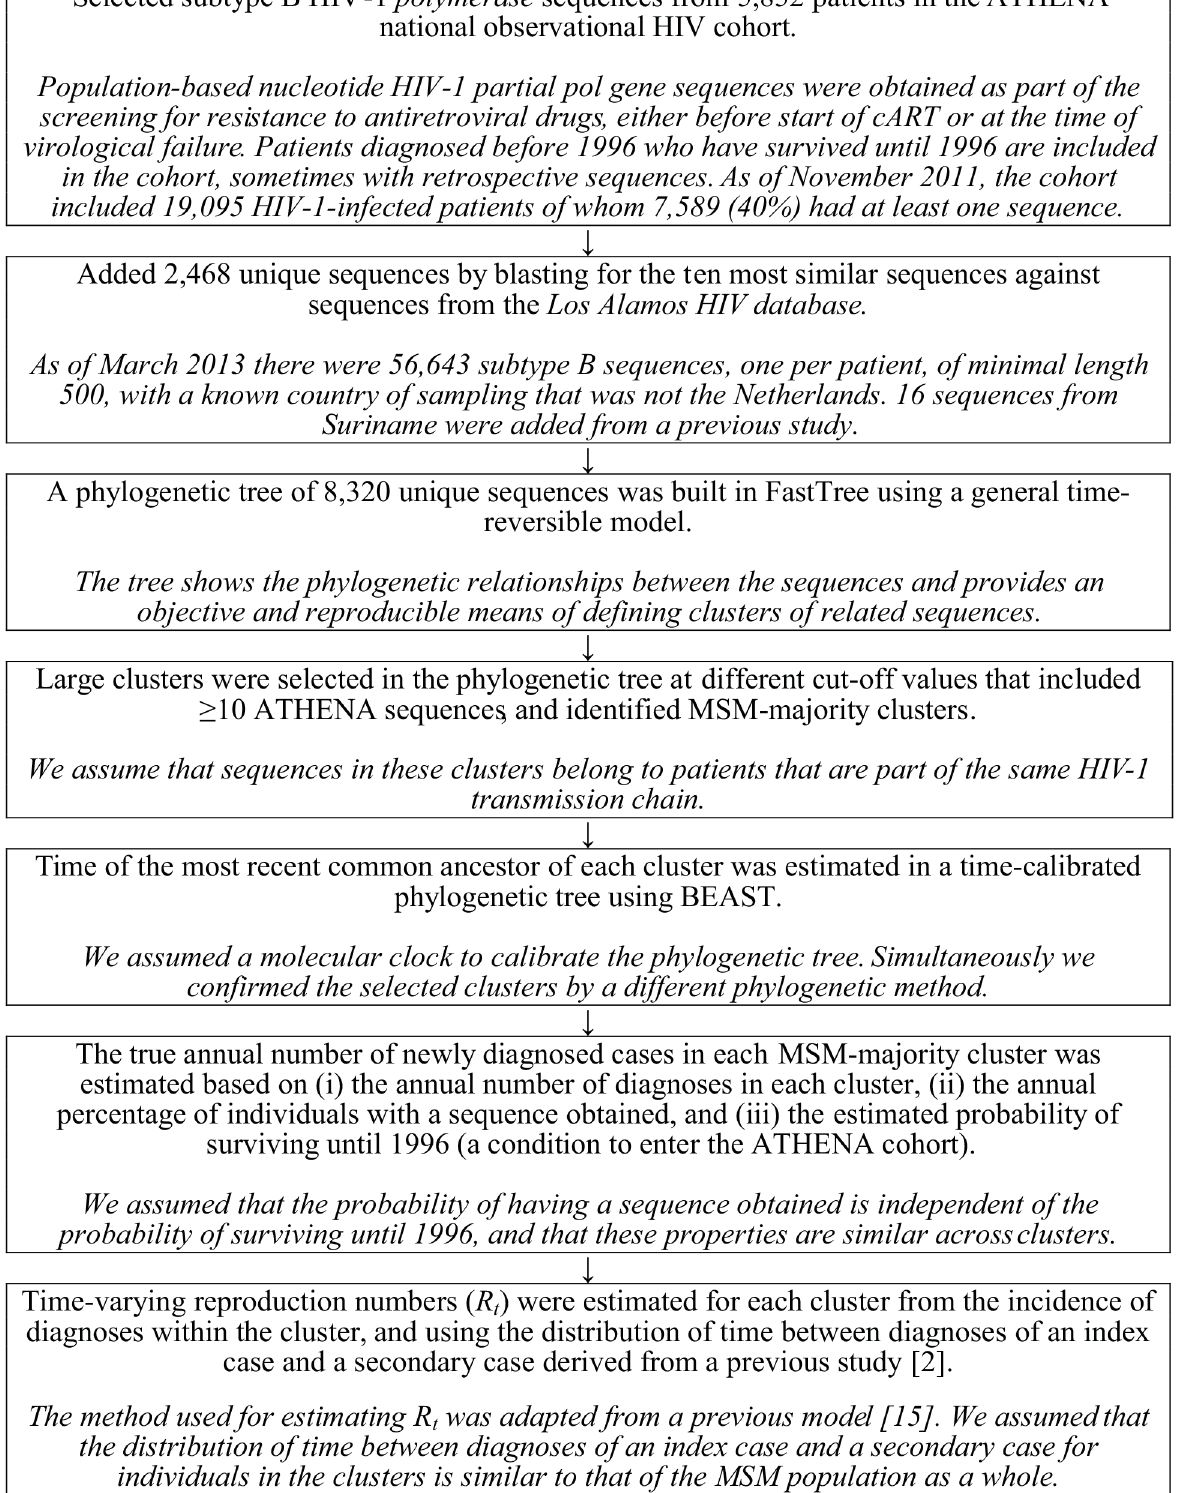
Fig 1. Flow diagram describing the methods and underlying assumptions.